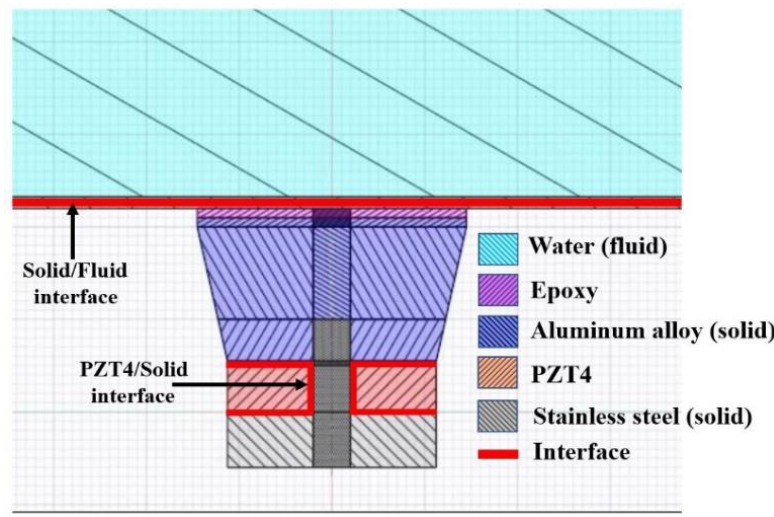
Figure 1. Material domains and interfaces.